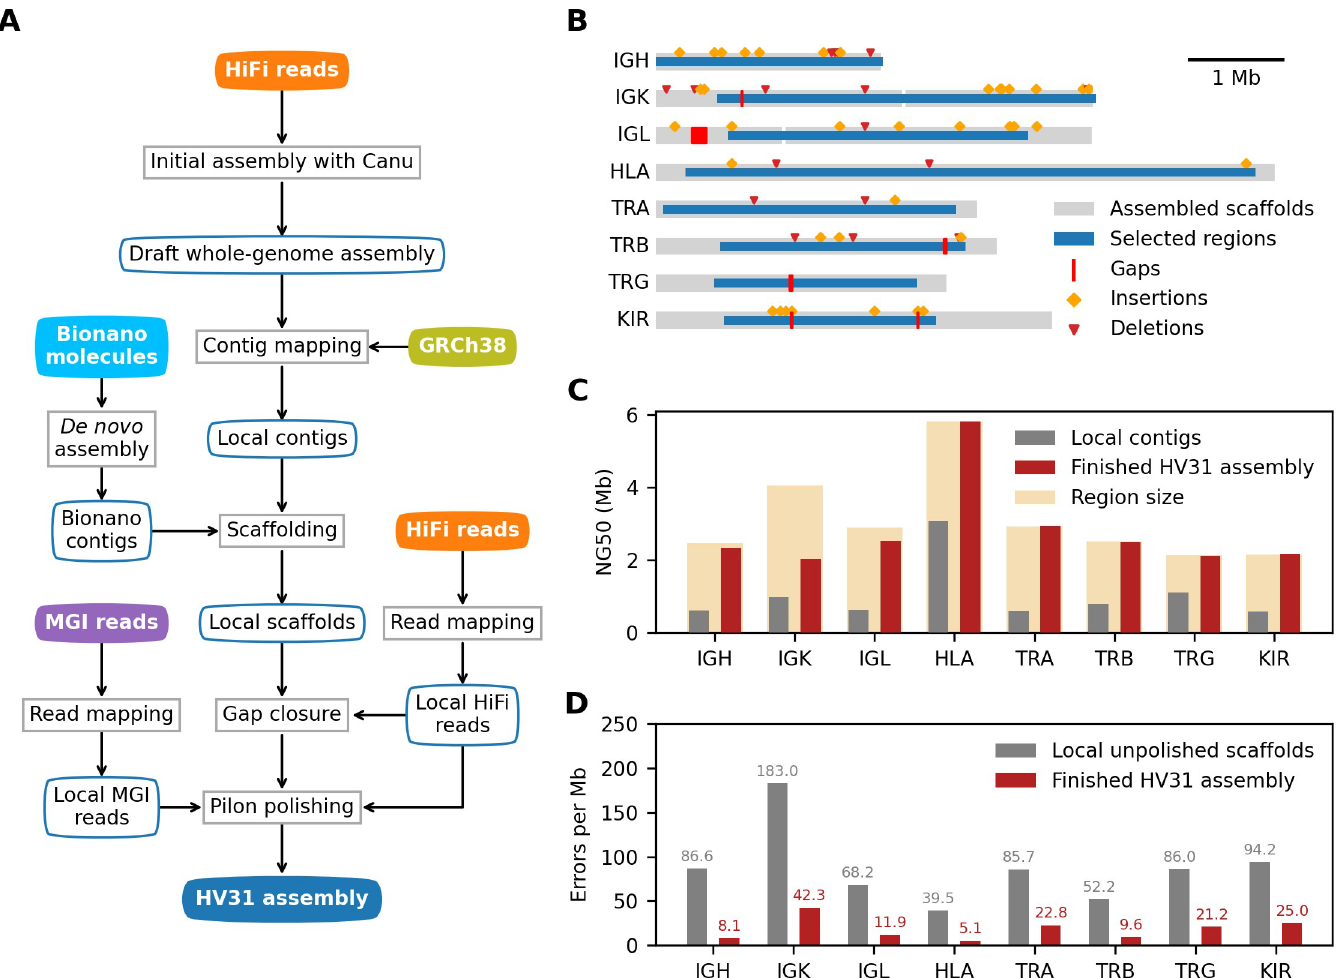
Fig 1. Evaluation of HV31 de novo assemblies. (A) Diagram of de novo assembly workflow. Processes and datasets are represented by blocks with square and rounded corners, respectively. (B) Overview of assembled scaffolds in 8 selected regions. Heterozygous SVs on the unassembled haplotype that are larger than 1 kb in size are shown as orange diamonds or red triangles. Note that the assembled scaffolds (gray) are often larger than the originally selected immune system regions (blue) defined in Table 1. (C) Contig/scaffold continuity (NG50, y axis) for local contigs (gray) and finished HV31 assembly scaffolds (red) in each region (x axis). NG50 is defined as the length of the longest contig/scaffold that, along with longer contigs/scaffolds, covers 50% percent of each locus, as determined by alignment to GRCh38. The size of the selected region on the GRCh38 reference is also shown. To ensure comparable results, for each contig/scaffold, only the length within region boundaries is taken into NG50 calculation. (D) The estimated number of errors per megabase in each region, before and after assembly polishing. Error rates are estimated using a modified version of the Merqury algorithm [24] as described in Methods.